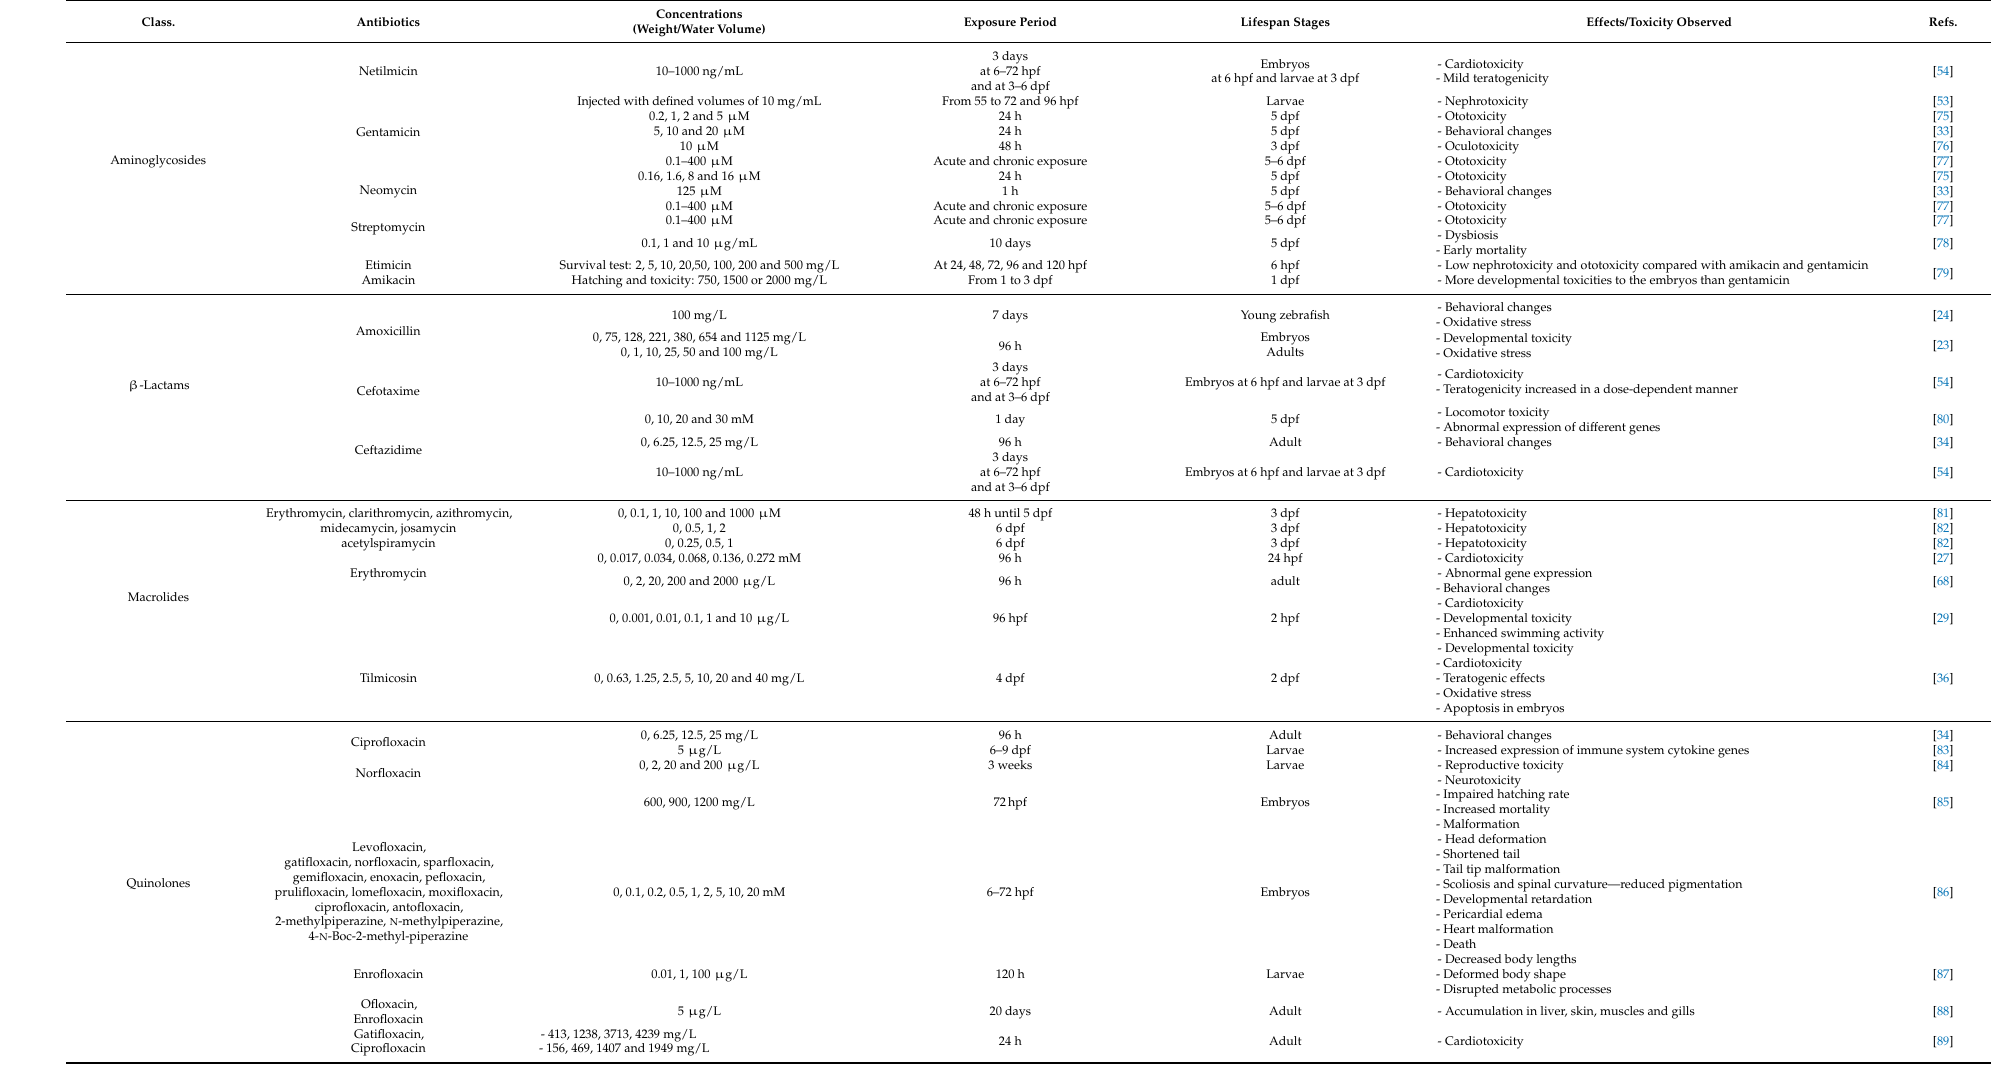
Table 1. Overview of the potential toxicological effects of individual antibiotics on zebrafish, dating from 2005 to the present.